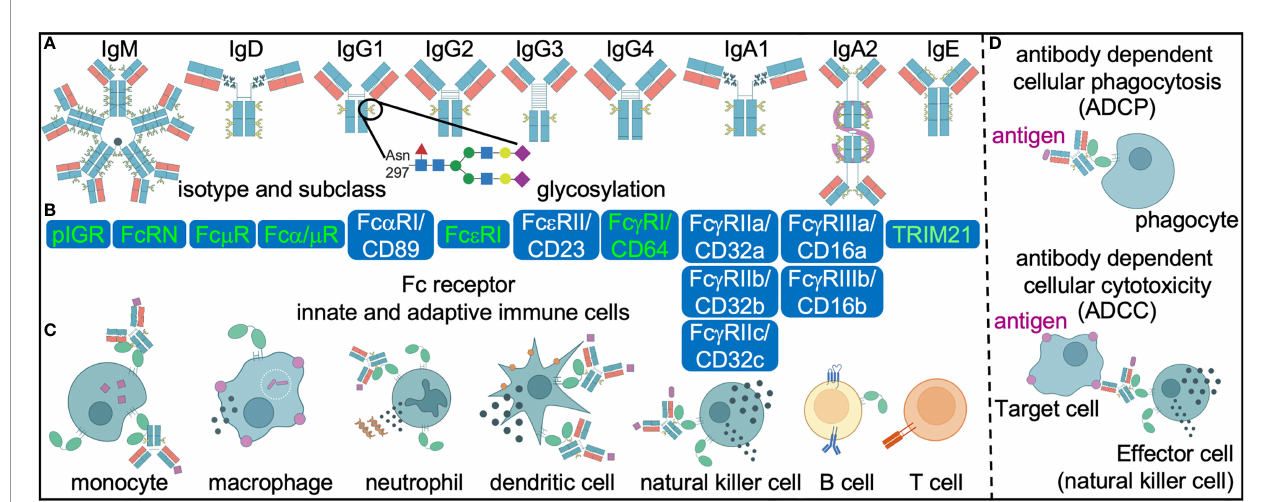
FIGURE 2 | Differential antibody engagement with Fc receptors mediate diverse innate and adaptive immune cell effector functions. Antibody diversity (A) in antigen speci fi city (theoretical n=10 13 ), isotype (n=5), subclass (n=6) and post-translational glycosylation (theoretical n=36 possible different moieties) in fl uence engagement of Fc receptors. Subsequent differential activation of high (red) and low (white) af fi nity Fc receptors (B) expressed on innate and adaptive immune cells (C) have the potential to mediate effector functions such as antibody dependent cellular phagocytosis and cytotoxicity (D) that in concert determine the heterogenous outcomes in human